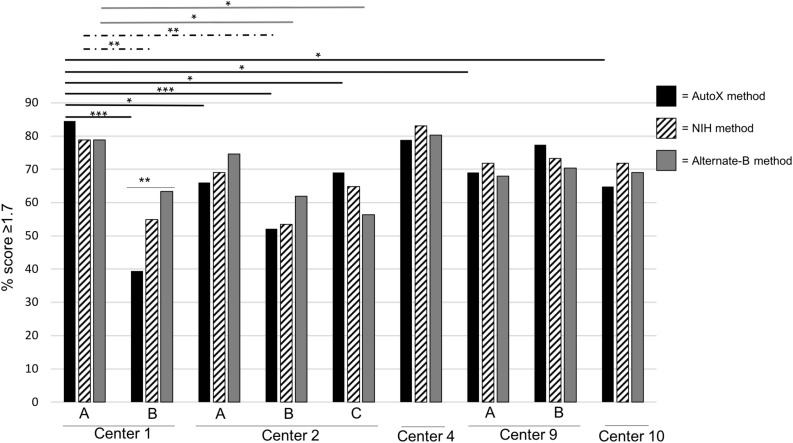
Comparative Analysis of Three Different Spectral Acquisition Methods Using a Single Prepared Plate (2018). Fresh extracts for 71 isolates were prepared at Center 1 and distributed to each institution. For each instrument, a freshly spotted plate was made and spectra were acquired on the same day in this order of spectral acquisition methods: (1) MBT_AutoX method (black bars and lines); (2) NIH method (hashed bars and lines); and (3) Alternate-B method (gray bars and lines). Multiple instruments in a single center are denoted by letters. ∗p < 0.05, ∗∗p < 0.005, ∗∗∗p < 0.0005.